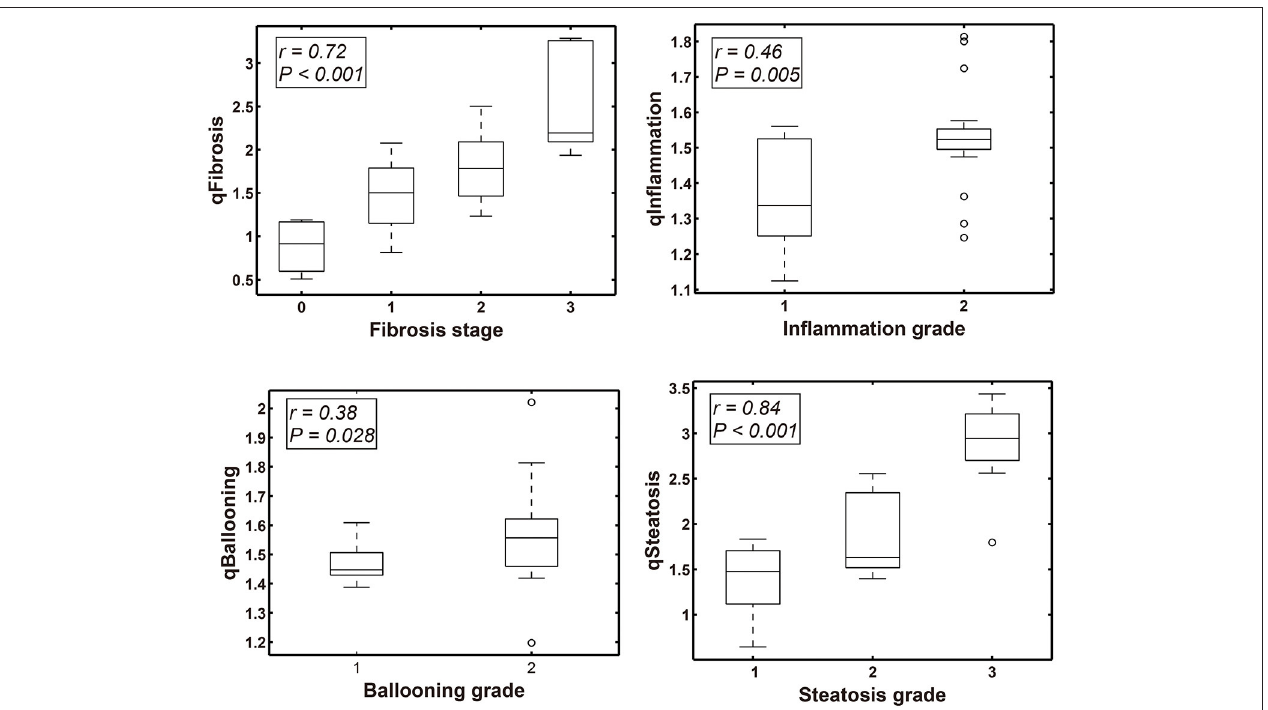
FIGURE 2 | Box-Whisker plots show the correlation between qFIBS indices (qFibrosis, qInflammation, qBallooning, and qSteatosis) and Non-alcoholic Steatohepatitis Clinical Research Network (NASH CRN) score component in the pediatric validation group.